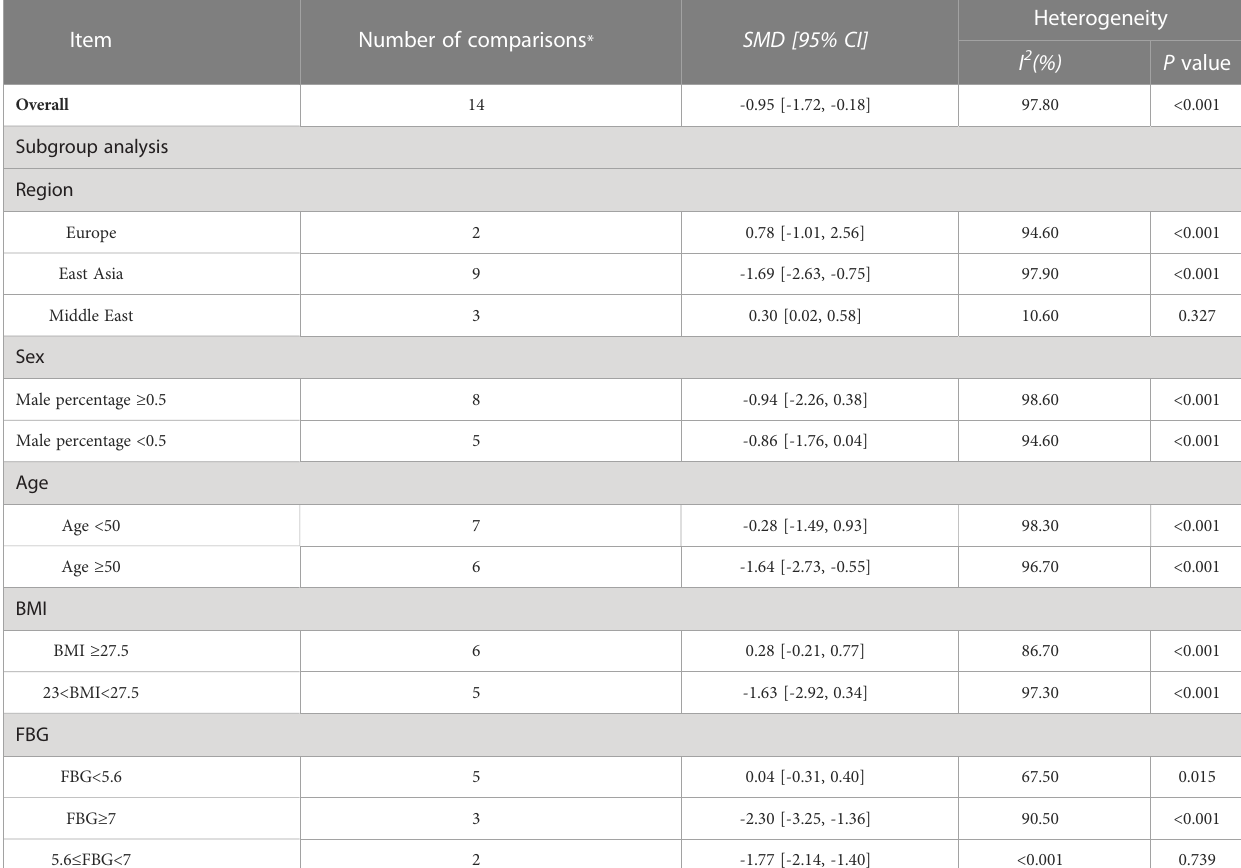
TABLE 3 subgroup analysis of circulating omentin levels between MAFLD and healthy control